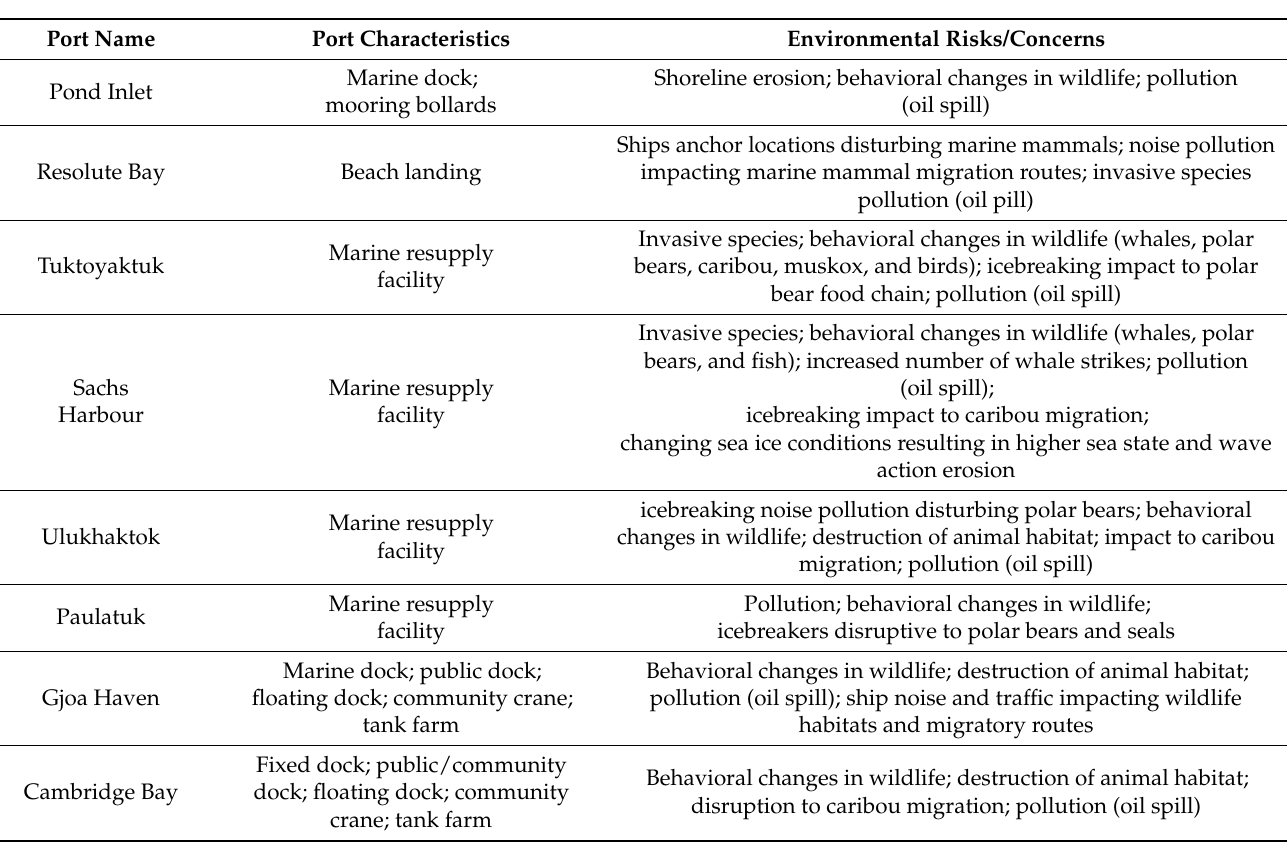
Table A2. Summary table of Canadian Arctic coastal ports.